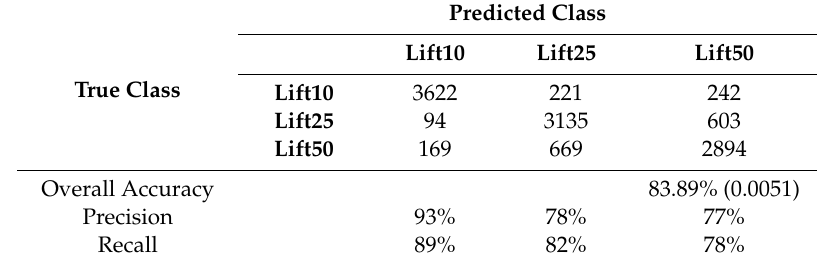
Table 14. Confusion matrix and class report of random forest classifier on different lifting weights.